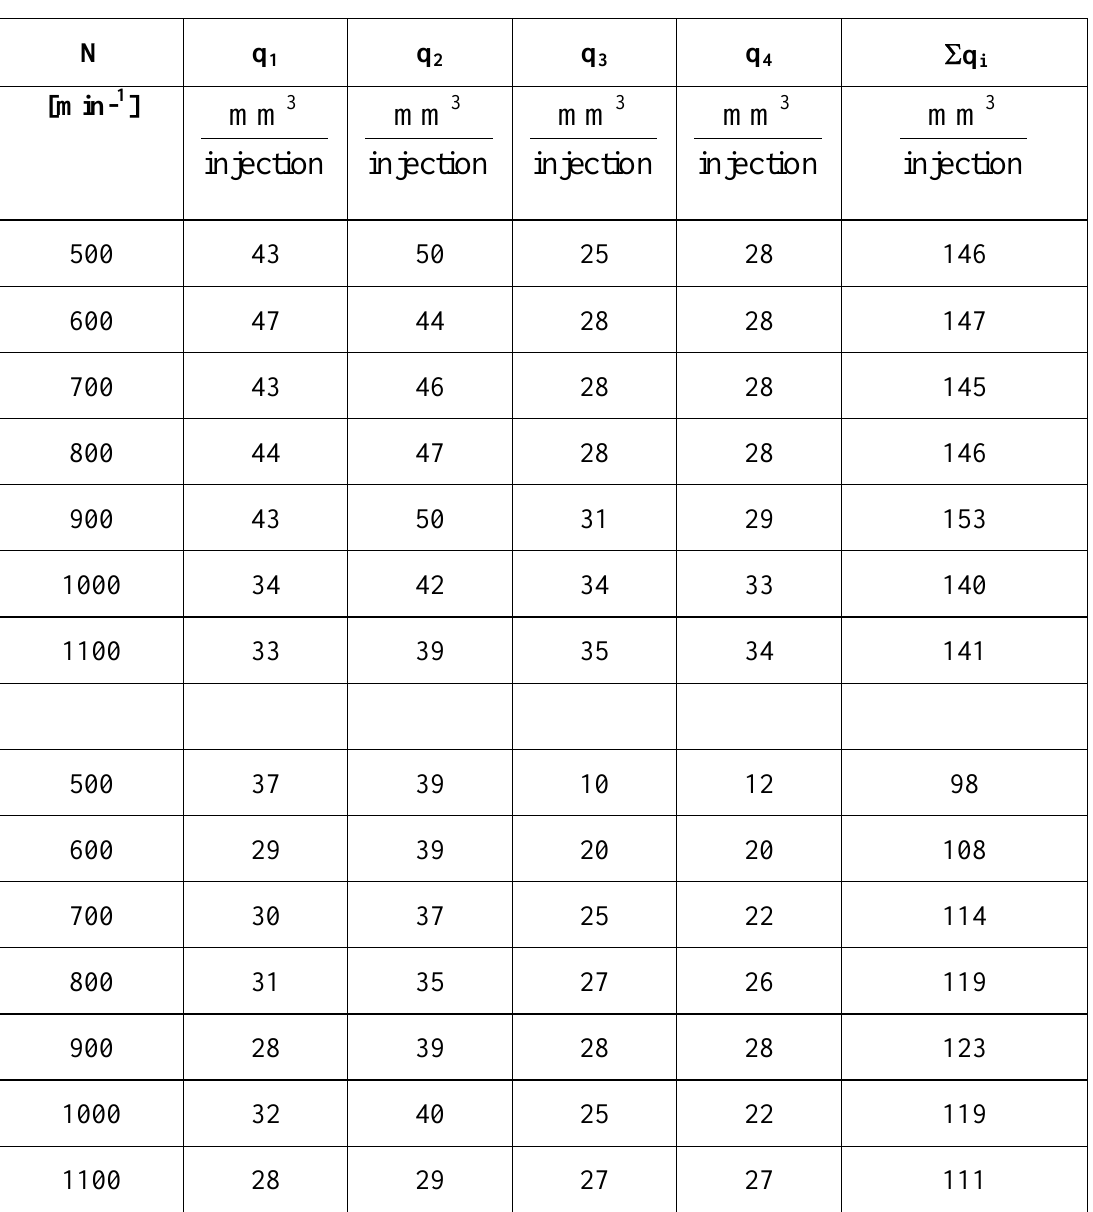
Table 2. Results of